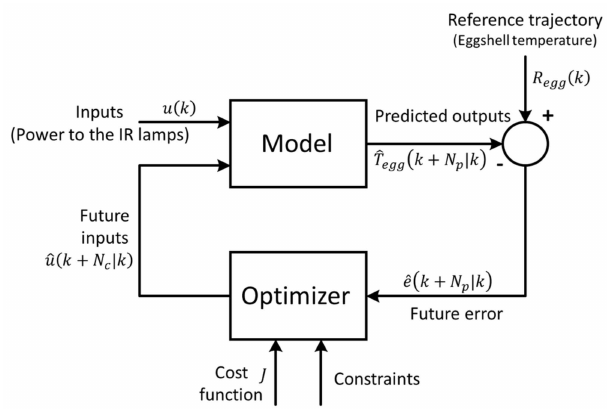
Figure 7. Block diagram representing the basic structure of the proposed MPC system to control the eggshell temperature of incubated